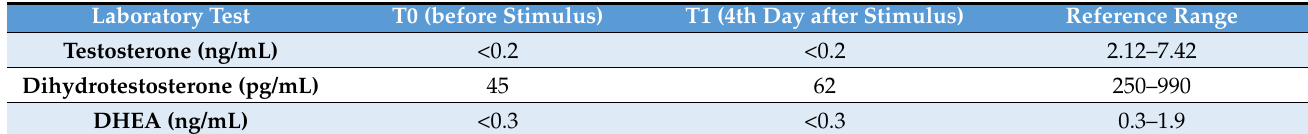
Table 3. Serum steroid levels before and after stimulation with hCG.